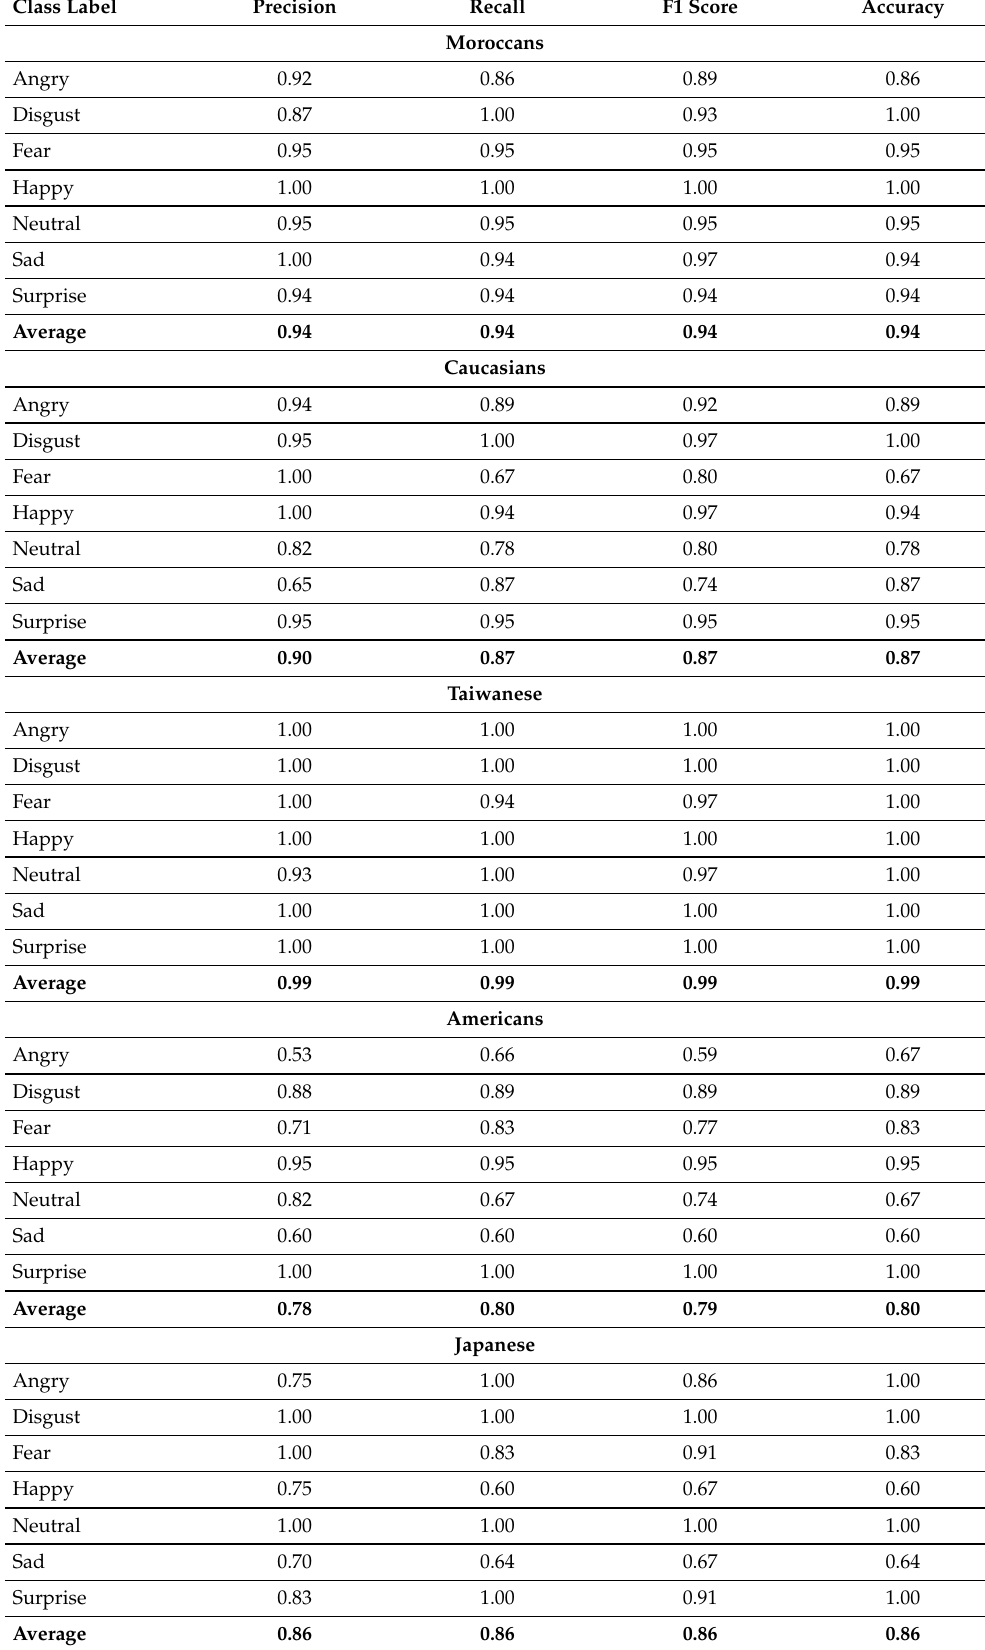
Table 5. Precision, recall, F1 score and accuracy score of our proposed method multicultural